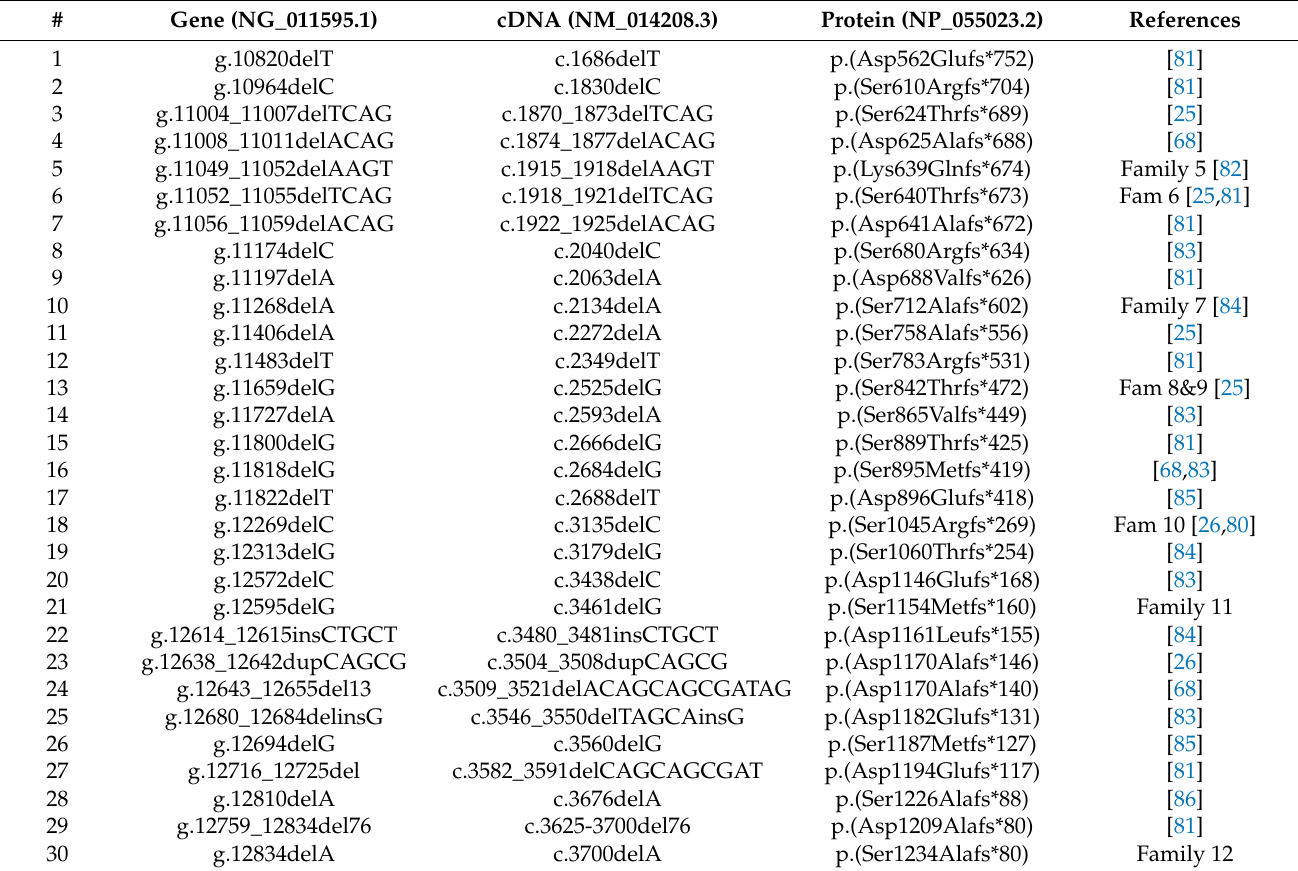
Table 2. 3 (cid:48) - DSPP (C-terminal) Disease-Causing